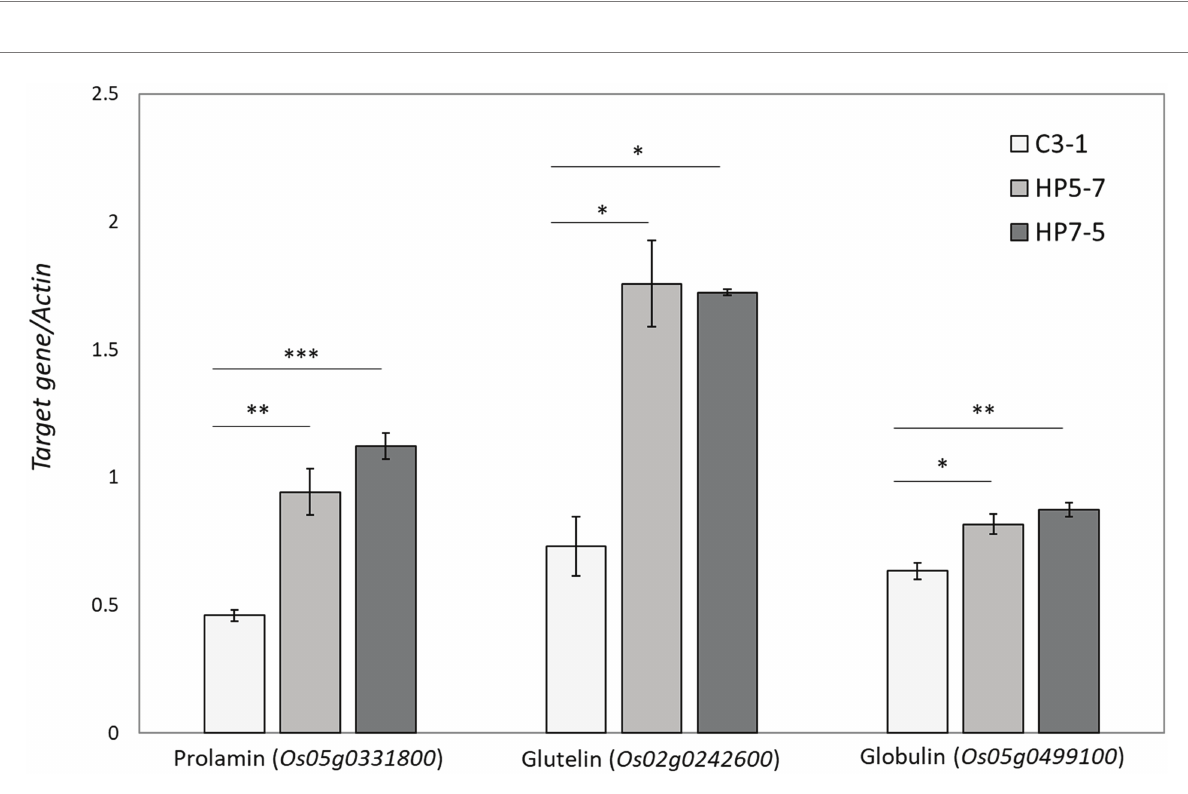
FIGURE 5 Validation of expression patterns of the selected three genes by qRT-PCR. The expression level of each gene was calculated relative to that of the Actin g ene that served as an internal standard. Data shown are the mean ± SD of three replicates. A statistically significant difference between the mean values was inferred from Student’s t -test (* p < 0.05, ** p < 0.01, and *** p <